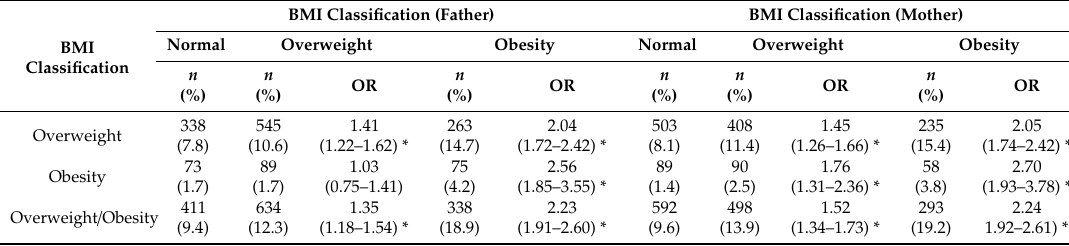
Table 4. Odds ratio values for overweight, obesity and overweight or obesity in children depending on the BMI classification of the father and mother (overweight vs. normal and obesity vs. normal).